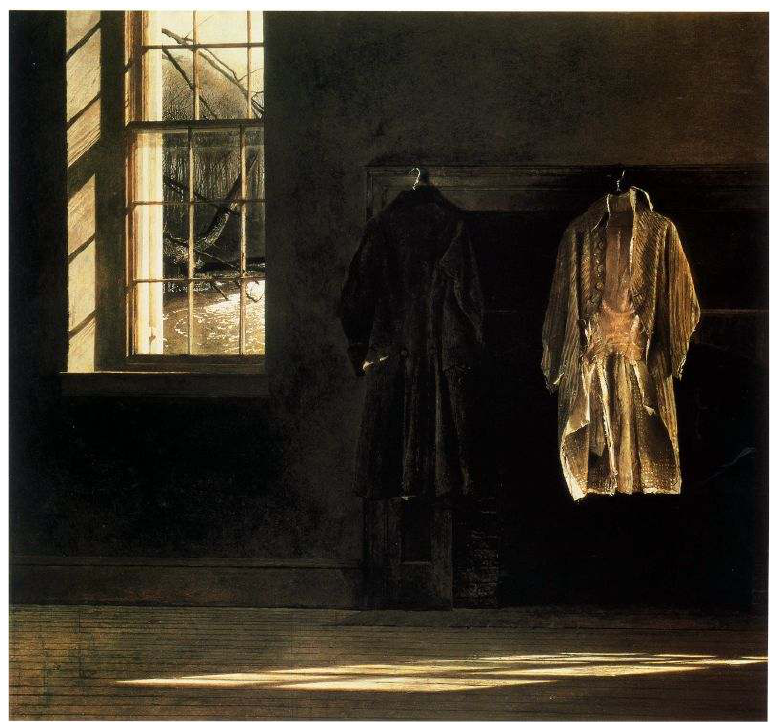
Source : https://missfolly.tumblr.com/post/8940445549/andrew-wyeth-the-quaker-1976 The painting represents a wall section, showing, on the left, a snowy landscape through an open window, and on the right, the left part of a fireplace, from which two costumes are hanging. 33 We can see the back of a Quaker frock coat, and the front of an elegant and expensive-looking “fop’s coat” (Wyeth 103). The opulence of the morning coat, with its fine green, blue and red stripes on a golden background, matching buttons, and pale pink lining, shimmering in a beam of light coming from the right-hand side of the picture, 34 stands in sharp contrast with the plainness of the Quaker coat, and the bare shadowy surroundings (sanded floor, wooden window frame, walls painted in olive green, carved wood and brick